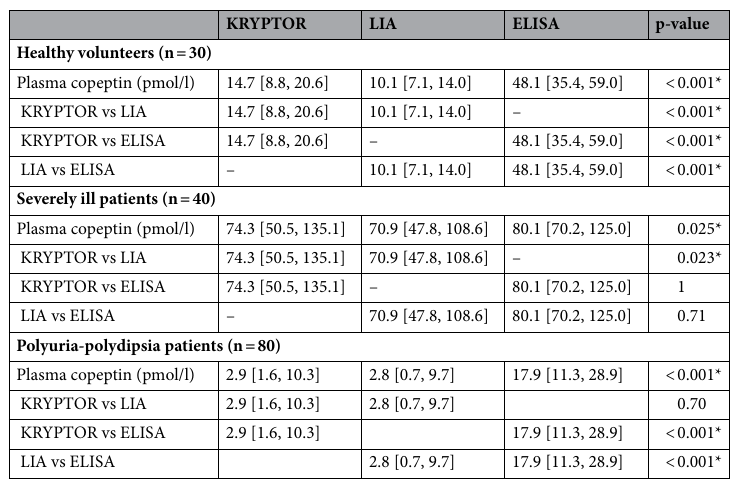
Table 2. Median copeptin concentrations of all three patients’ cohorts at any measured timepoint using the three different copeptin assays. Copeptin was measured in duplicates with the KRYPTOR, the LIA and the ELISA. Continuous variables are expressed as median [interquartile range]. Three-group comparison was done using the Friedman Test. Posthoc two group comparison was done using the paired Wilcoxon Sign Rank Test with Bonferroni p-value adjustment. *Statistically